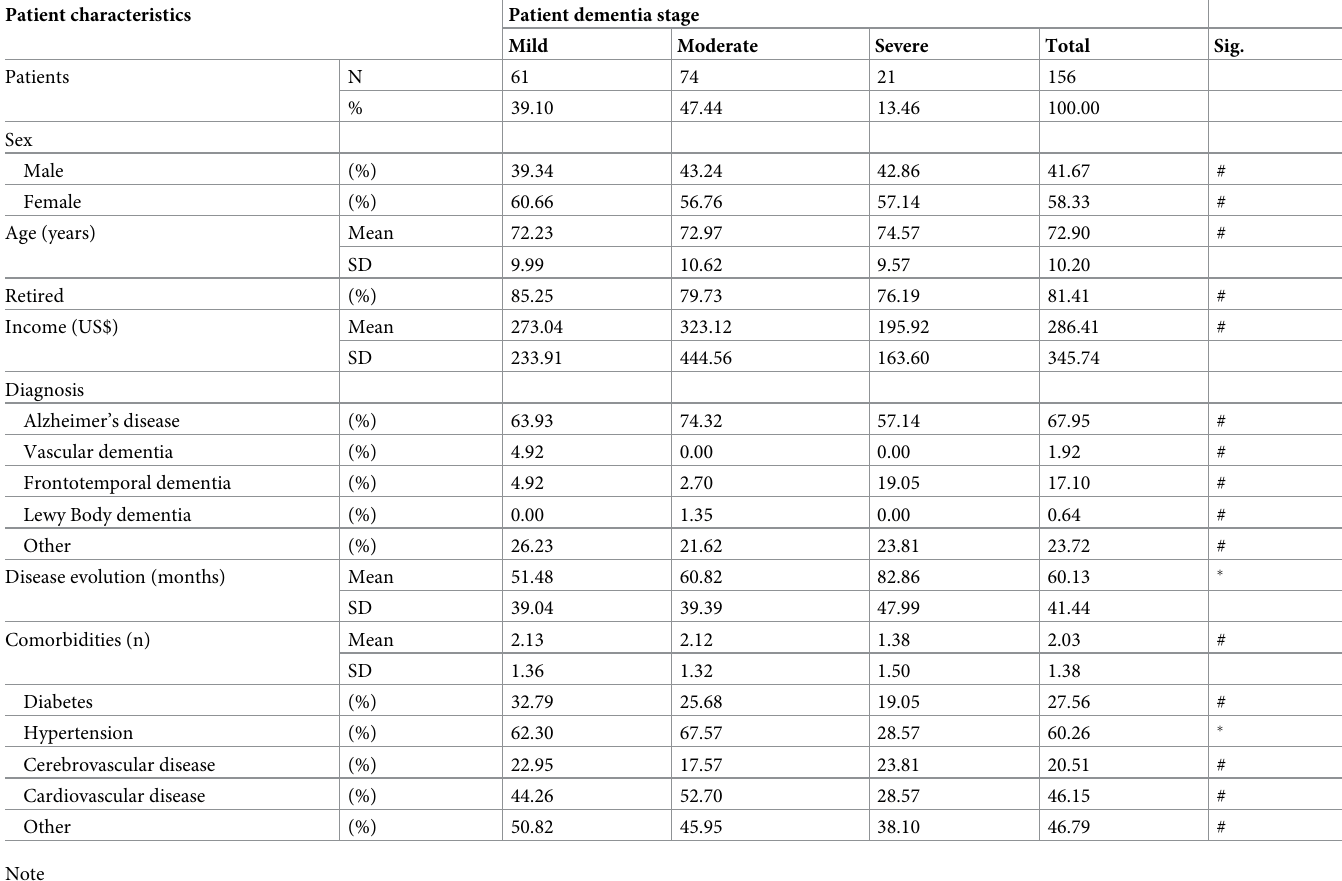
Table 1. Sociodemographic characteristics and clinical status of patients, according to patient FAST category. Brazil, 2016. Patient characteristics Patient dementia stage Mild Moderate Severe Total